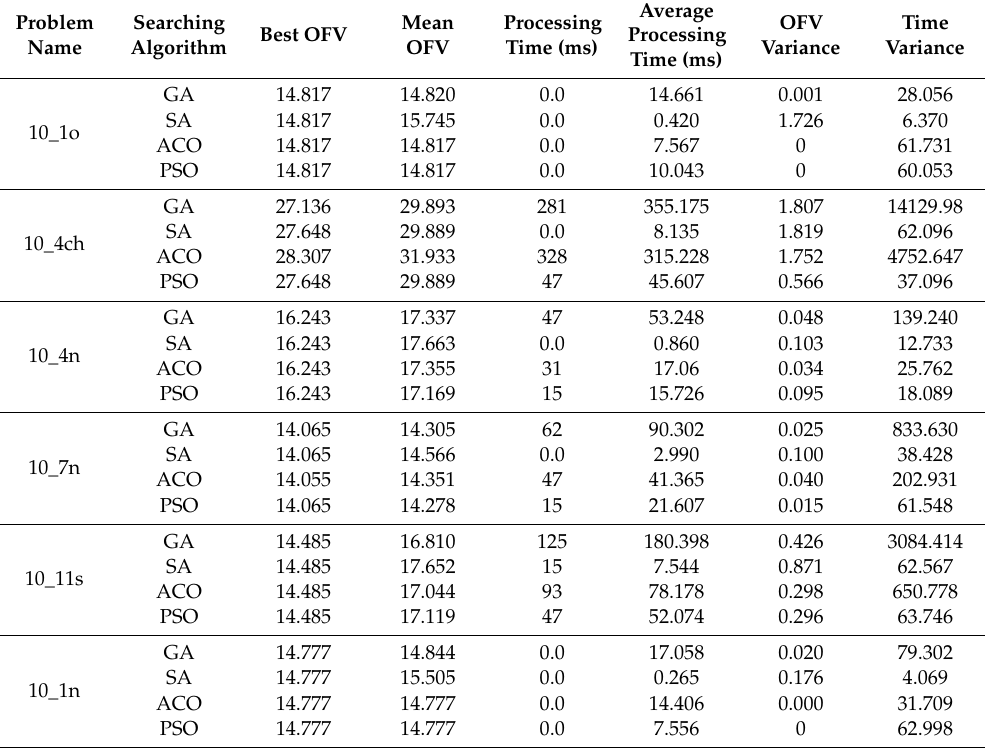
Table 10. Experimental results of the metaheuristic algorithms within 10 × 10 case.